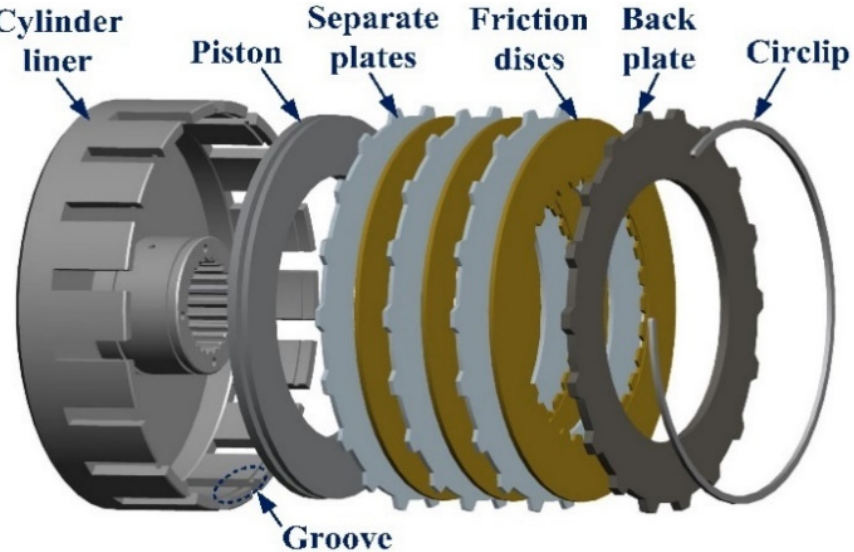
Figure 2. Exploded layout of the multidisc clutch.